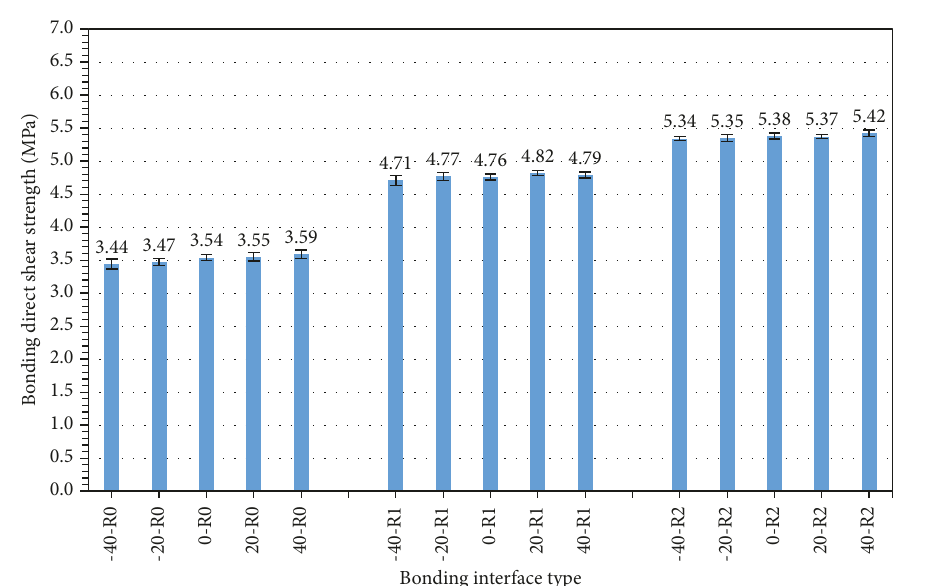
Figure 27: Bonding direct shear strength at different interface types and different temperatures.